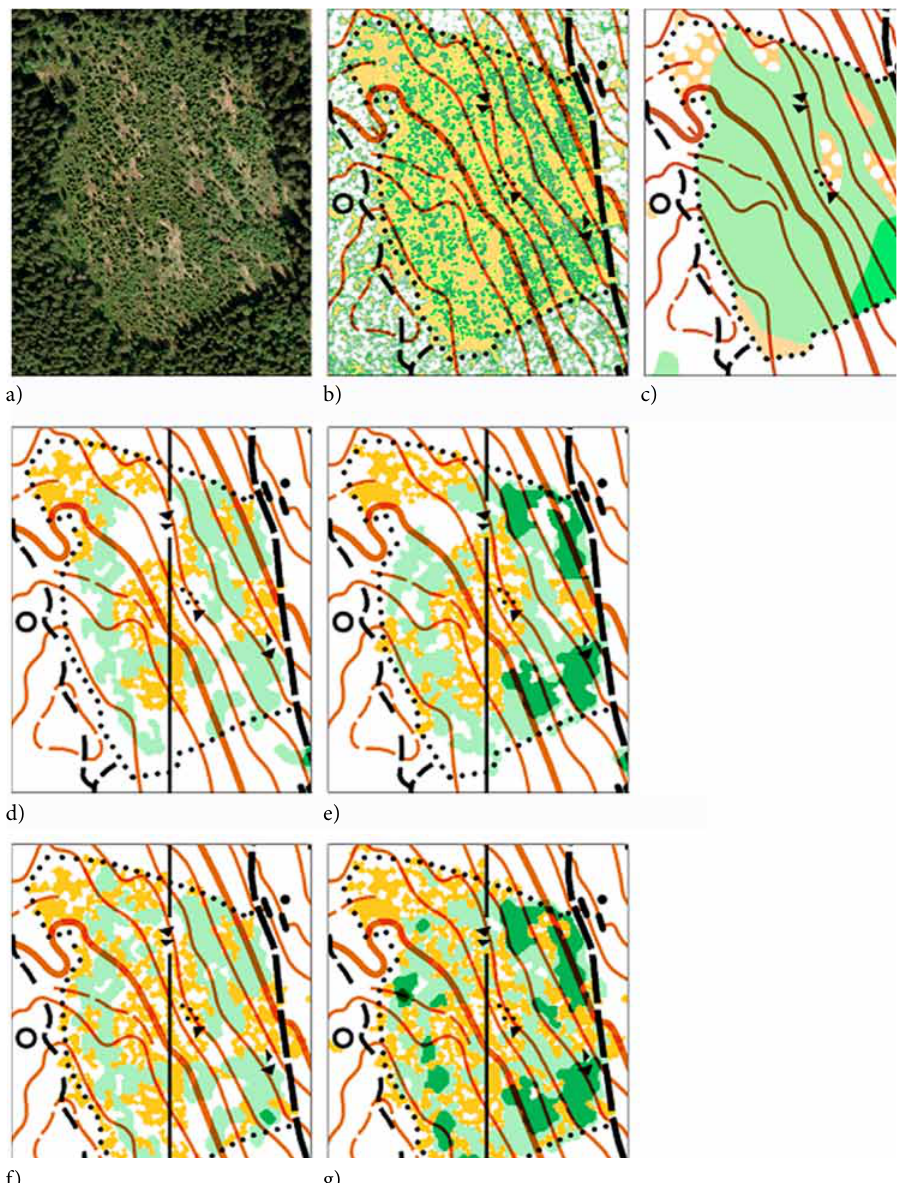
Fig. 12. Inspection of a small area from the Tryvann area. (a) Air photo of 13 june 2011. (b) Vegetation height. (c) Manual survey. (d) Automatic mapping on 2/m 2 data, minimum area of colour tone = 225 m 2 . (e) Automatic mapping on 10/m 2 data, minimum area = 225 m 2 . (f) Automatic mapping on 2/m 2 data, minimum area = 22.5 m 2 . (g) Automatic mapping on 10/m 2 data, minimum area = 22.5 m